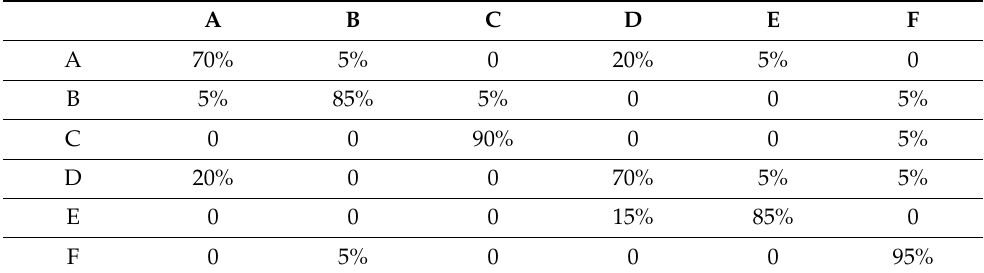
Table 6. Confusion matrix achieved for the Common variety accessions of set 2: A, Pera Abril IAC